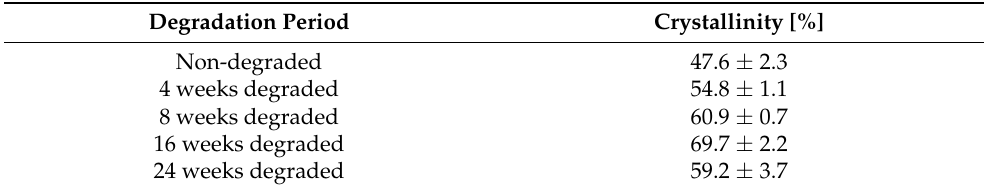
Table 1. Crystallinity of the stents depending on the degradation period.